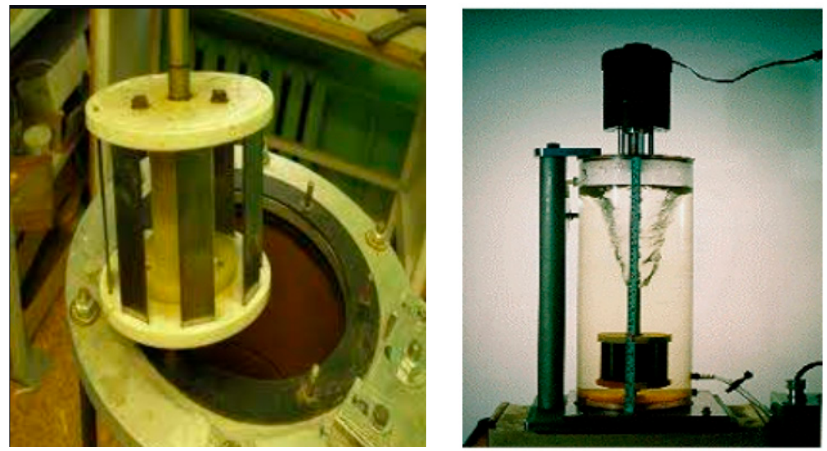
Figure 13. Instrument for the rotating cage test [123].